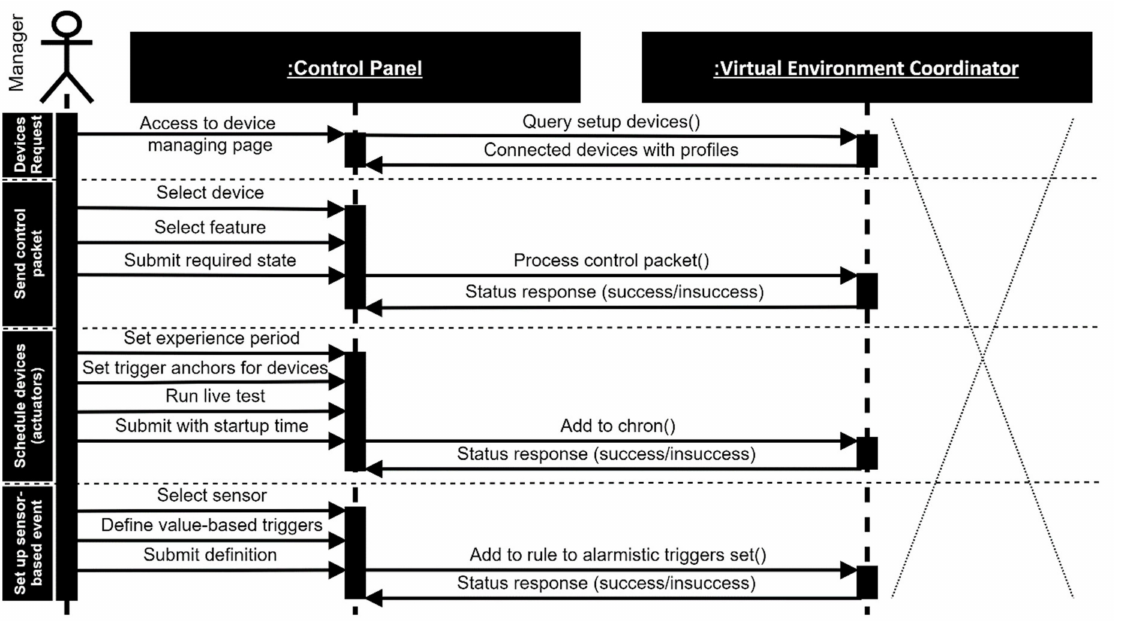
Figure 4. Sequence diagram depicting the four possible interactions between the IoT server (via control panel interface) and the virtual environment (using the virtual environment coordinator), regarding control and managing activities: (1) devices request returns a list of usable equipment; (2) send control packet results in a device state switching; (3) in schedule devices , a time-based rules set ( trigger anchors ) is defined to establish a limited temporal sequence for device state switching; finally, (4) set up sensor-based event shows the process to specify triggers for switching the state of a given device as a consequence of another device behavior—considering that, typically, a sensor can influence an actuator—as long as both belong to the same